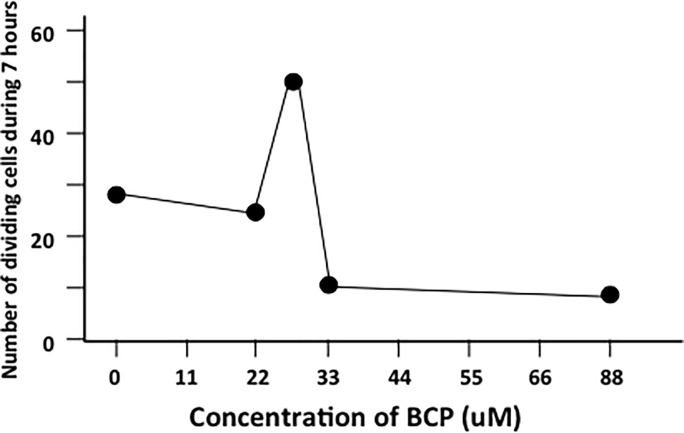
Proliferating primary fibroblast cells exposed to BCP at various concentrations.Number of dividing and apoptotic cells during 7 hours of exposure to BCP.